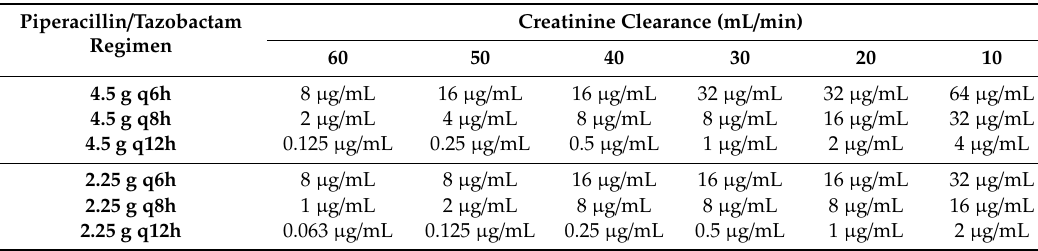
Table 4. Pharmacokinetic/pharmacodynamic breakpoints for piperacillin regimens in patient populations with various degrees of creatinine clearance.